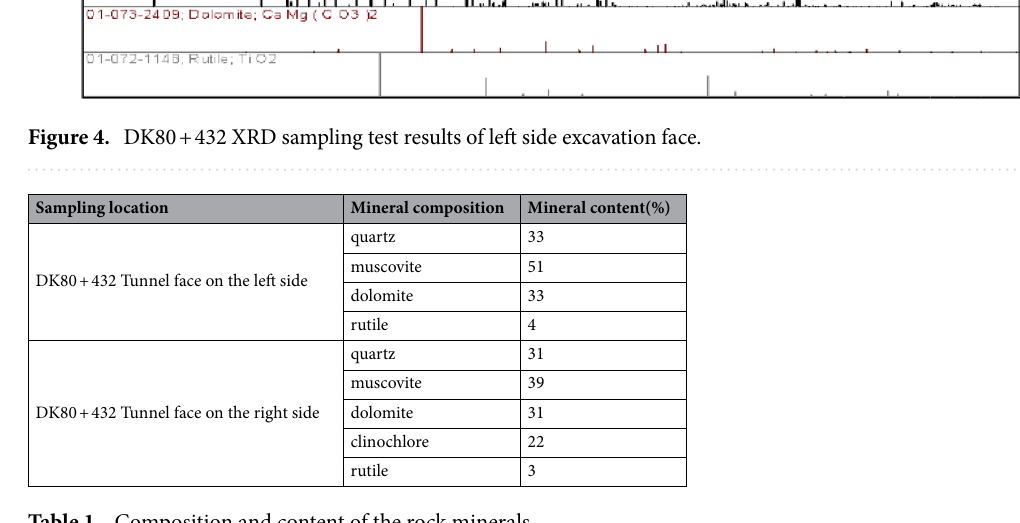
Table 1. Composition and content of the rock minerals.